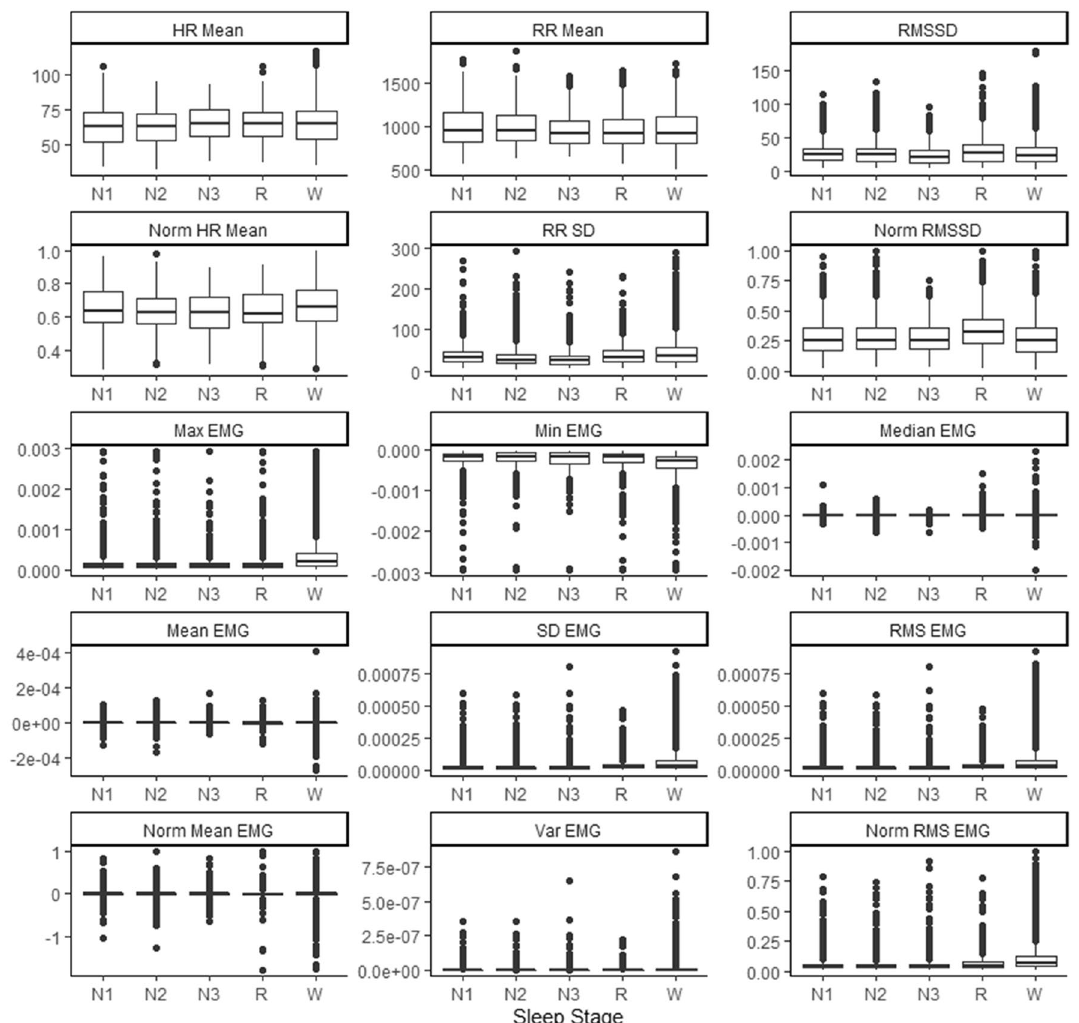
Figure 4. Box and whisker plots of each feature (titles), with sleep stage on the x-axis and relevant units on the y-axis. The y-axis of HR mean, and Norm HR mean are expressed as beats per minute (BPM), while RMSSD, RRSD and the normalized graph of these are expressed in milliseconds. The y-axis of all EMG graphs is expressed in microvolts (µV)Figure produced in R version 4.0.2 using ggplot2 package https:// cran.r- proje ct. org/ web/ packa ges/ ggplo t2/ index.